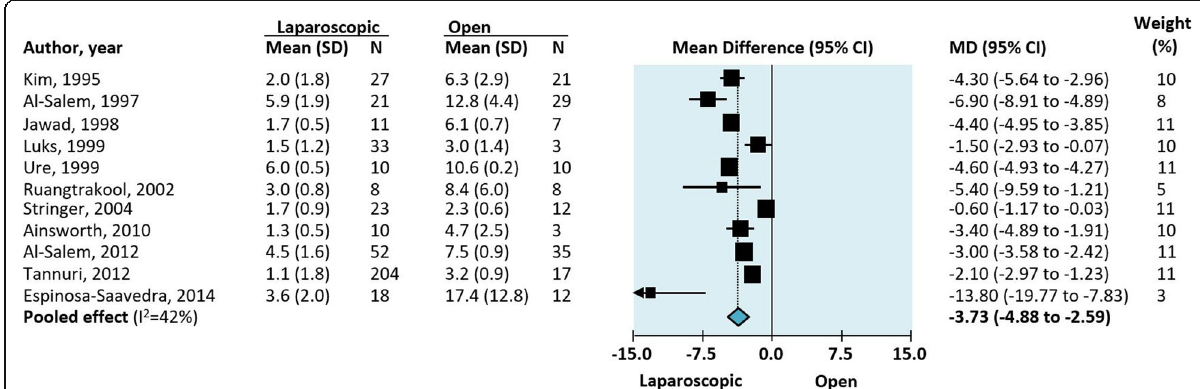
Fig. 4 Mean difference for the length of hospital stay (days) in studies comparing laparoscopic cholecystectomy versus open cholecystectomy. Studies ordered chronologically. Negative values favour laparoscopic cholecystectomy group. SD = standard deviation; N = sample size; CI = confidence interval; MD = mean